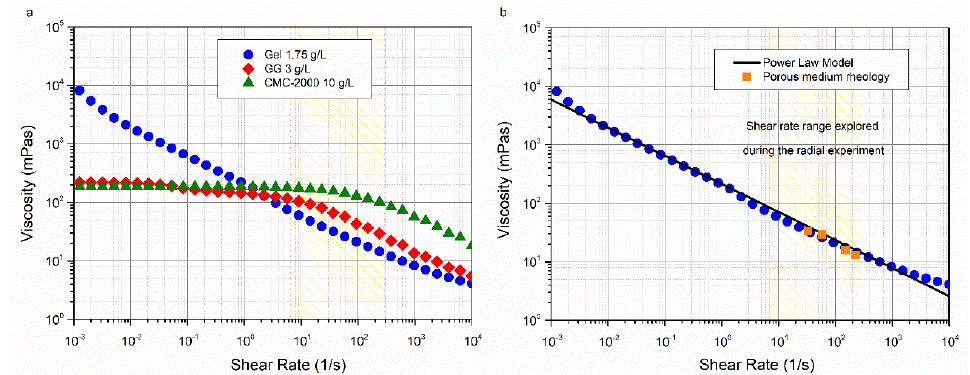
Figure 2. Rheological curves of CMC-2000 at 10 g / L, GG at 3 g / L and GG:XG at 1.75 g / L solutions ( a ), bulk and porous medium rheograms of the XG:GG mixture at 1.75 g / L ( b ): experimental data (point values) and model (solid line). CMC, carboxymethyl cellulose; GG, guar gum; XG, xanthan gum.